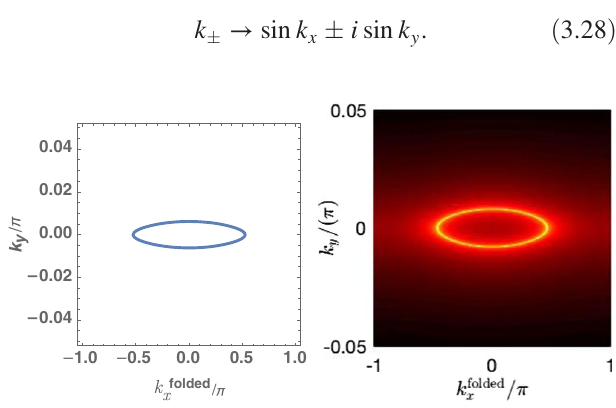
FIG. 4. FS from coupling the domain-wall modes. Left panel: FS obtained from Eq. (3.26), where the hopping parameters in Eq. (3.25) are computed for lattice parameters t 0 ¼ 1 , μ ¼ − 1 . 25 , Δ 0 . 82 , and Q ¼ π = 6 . Right panel: Simulated fermionic PDW ¼ spectral function ρ ð k ; E ¼ 0 Þ from a lattice nearest-neighbor hopping model subject to a PDW order